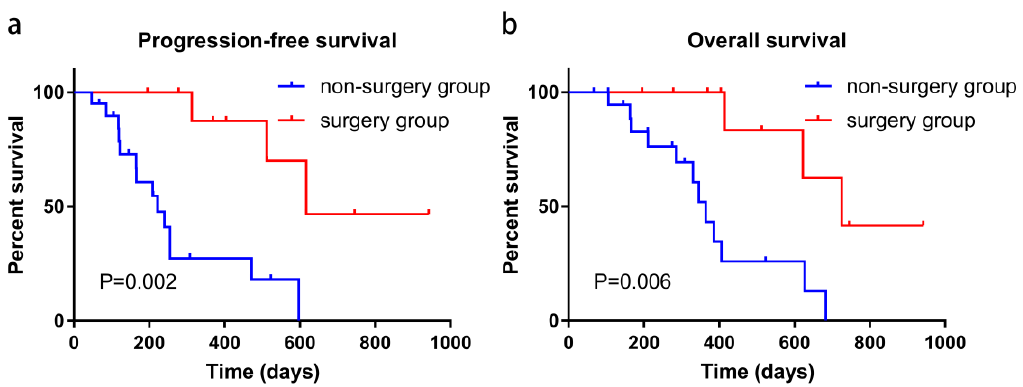
Figure 3. Kaplan–Meier curve analysis of PFS ( a ) and OS ( b ) in the surgery and non-surgery sub- groups. PFS, progression-free survival; OS, overall survival.